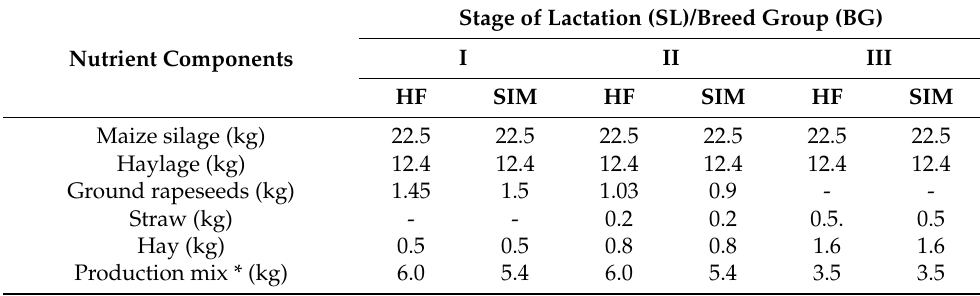
Table 2. Ingredients of the dairy cow diet in each stage of lactation and breed group (herd). Stage of Lactation (SL)/Breed Group Nutrient Components